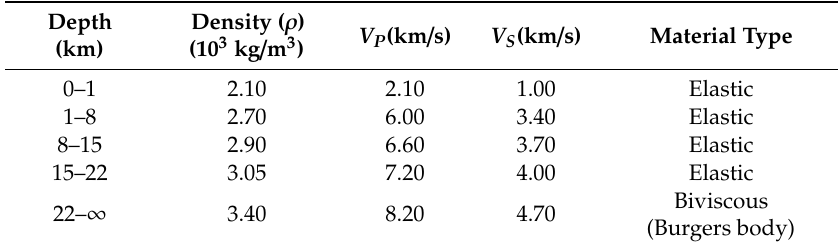
The 5-layer half-space Earth model used in the prediction of co- and post-seismic gravity changes. Depth